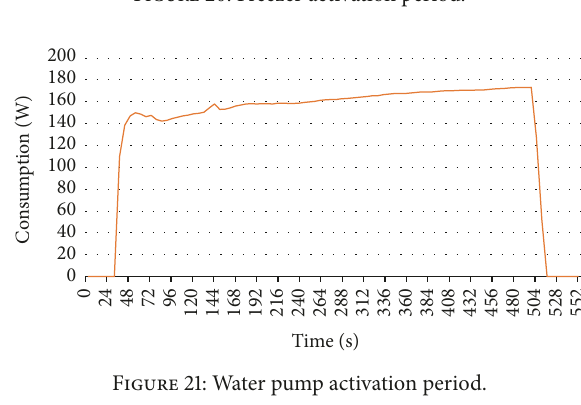
Figure 20: Freezer activation period.